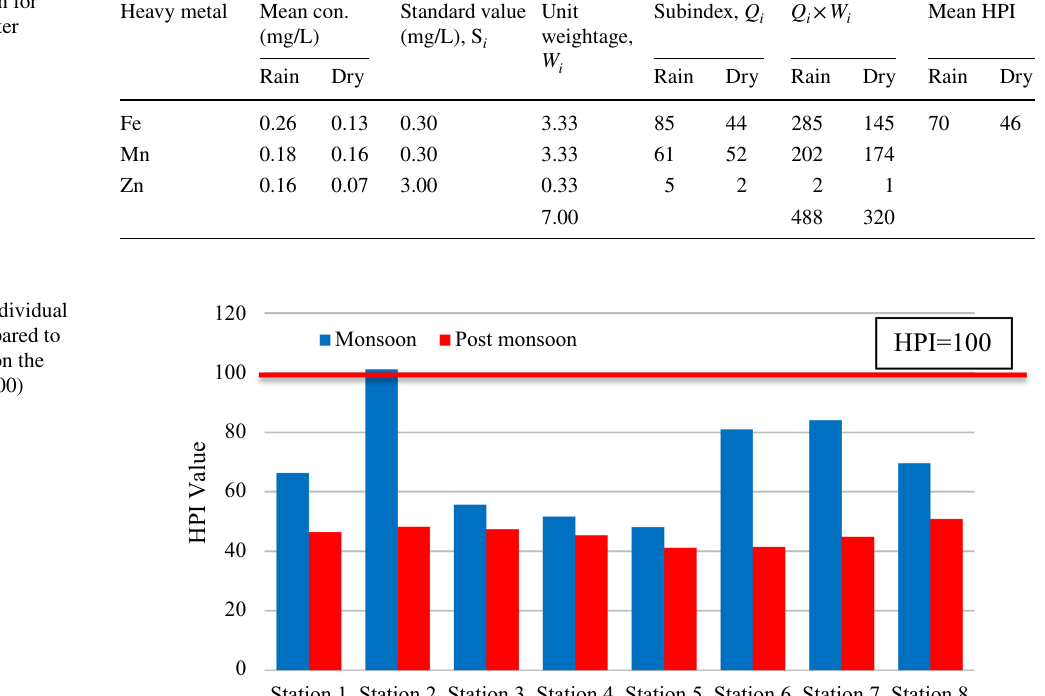
water sample in the water supply system